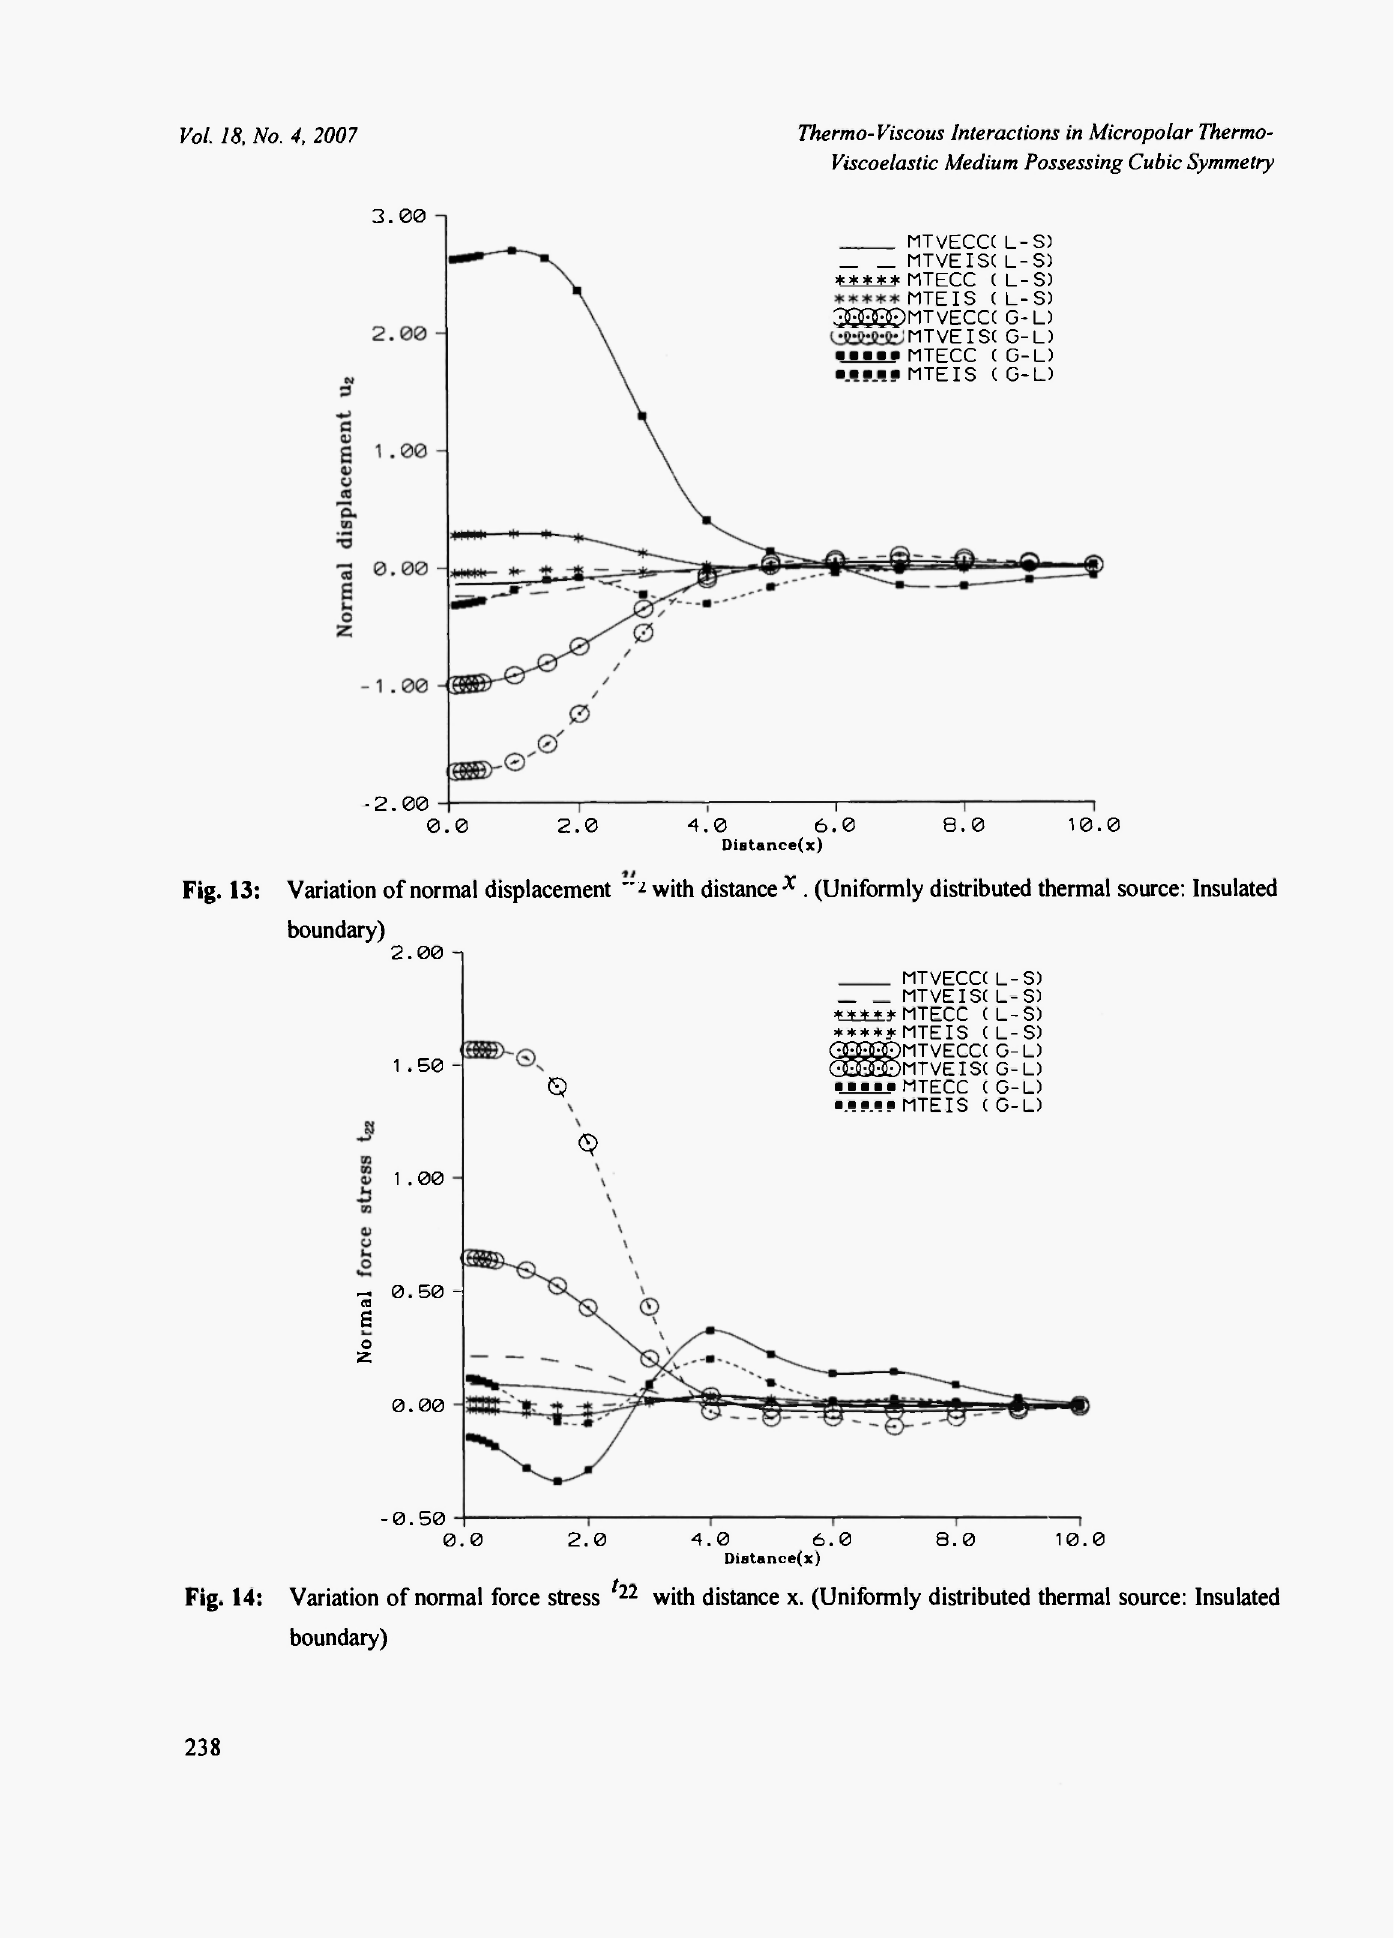
Fig. 14: Variation of normal force stress ' 22 with distance x. (Uniformly distributed thermal source: Insulated